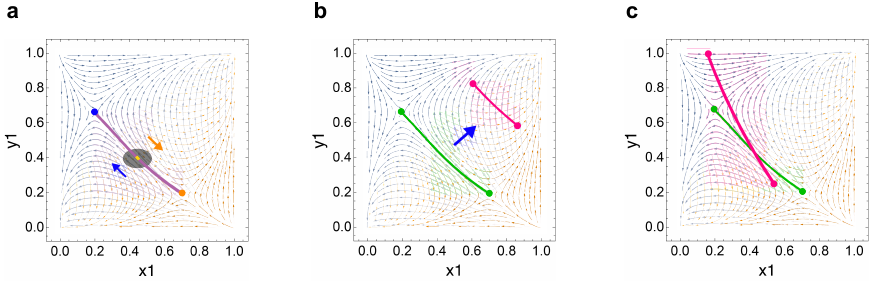
Figure 18. Treble of dynamics. ( a ) Market driven oscillatory dynamics. ( b ) Technology driven arc drift. ( c ) Policy driven arc